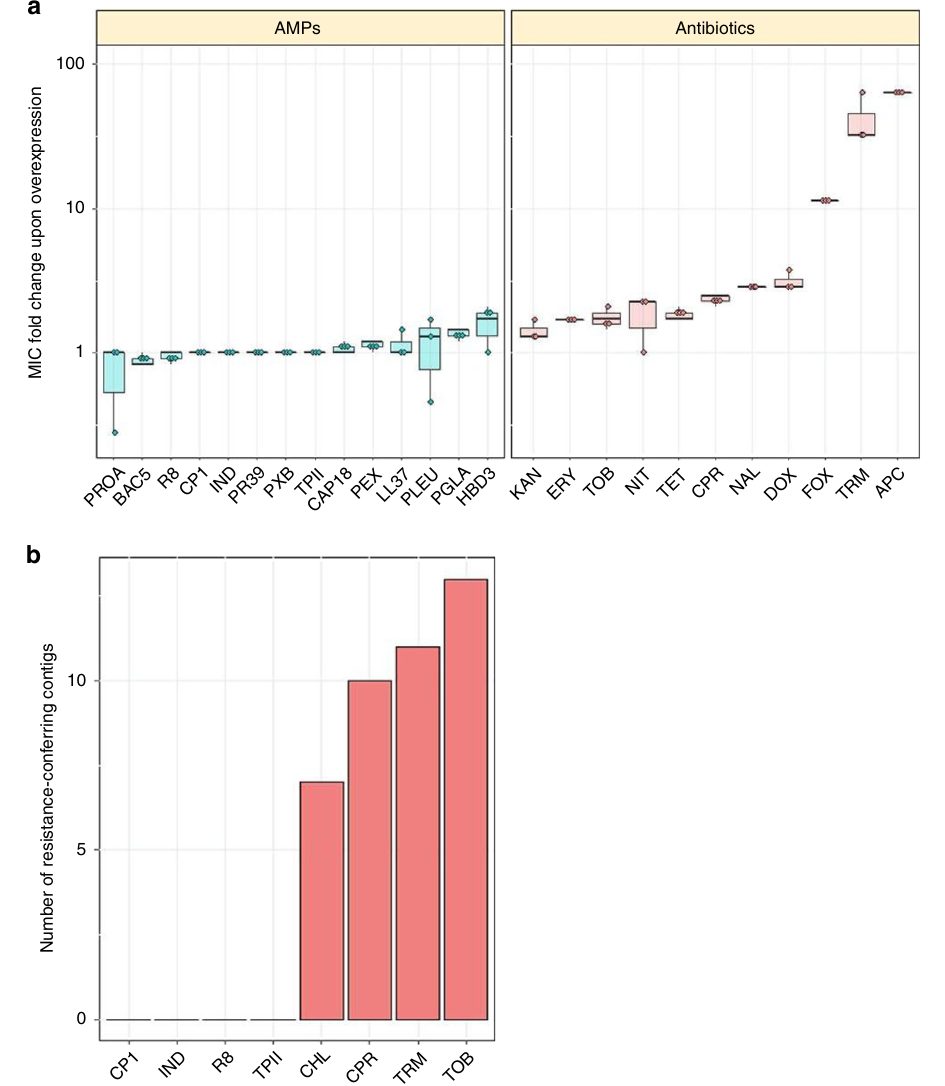
Fig. 6 Impact of gene ampli fi cation and foreign genes on resistance. a The impact of gene overexpression on resistance level. Dots represent show the MIC provided by the ASKA plasmid library relative to the MIC of the wild type carrying the empty ASKA plasmid (three biological replicates each). Altogether, the overexpression of the ASKA plasmid library resulted in signi fi cantly higher resistance to antibiotics ( N = 11) than for AMPs ( N = 14) ( P < 0.0001, one- sided permutation test). Each data point represents the MIC fold change of one of three biological replicate. Boxplots show the median, fi rst and third quartiles, with whiskers showing the 5th and 95th percentile. b Functional metagenomics of a soil library. Functional selection has revealed 41 distinct antibiotic resistance-conferring DNA contigs (red bars), while no AMP resistance-conferring contigs were identi fi ed ( P = 2 × 10 − 16 from two-sided negative binomial regression). For AMP and antibiotic abbreviations, see Supplementary Tables 1 – 2. Source data are provided as a Source Data fi